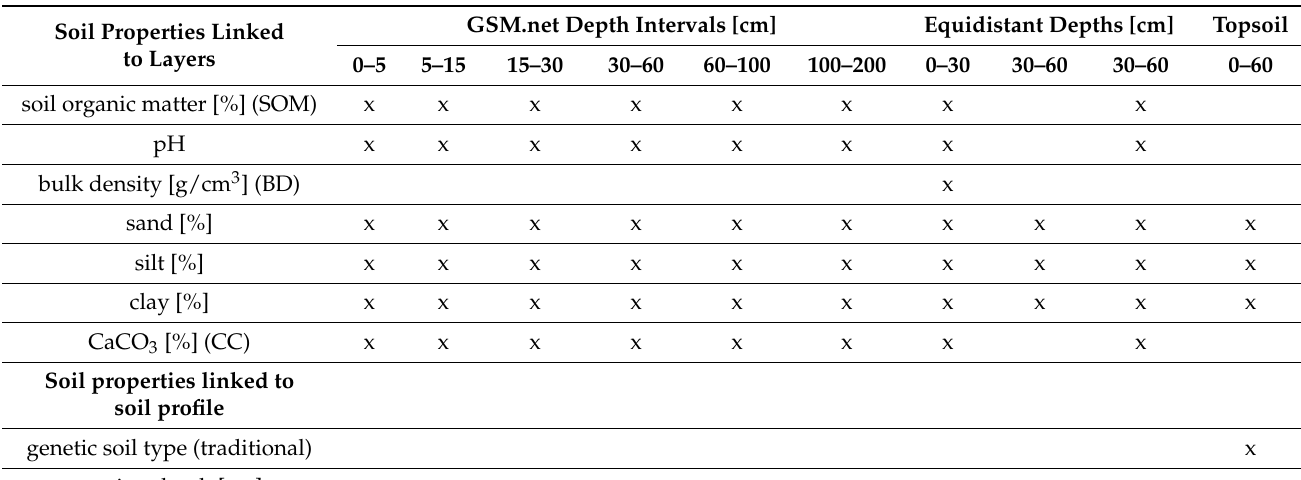
Table 1. Summary of the primary soil property maps used for the comparison of the pedological features of CMPs and